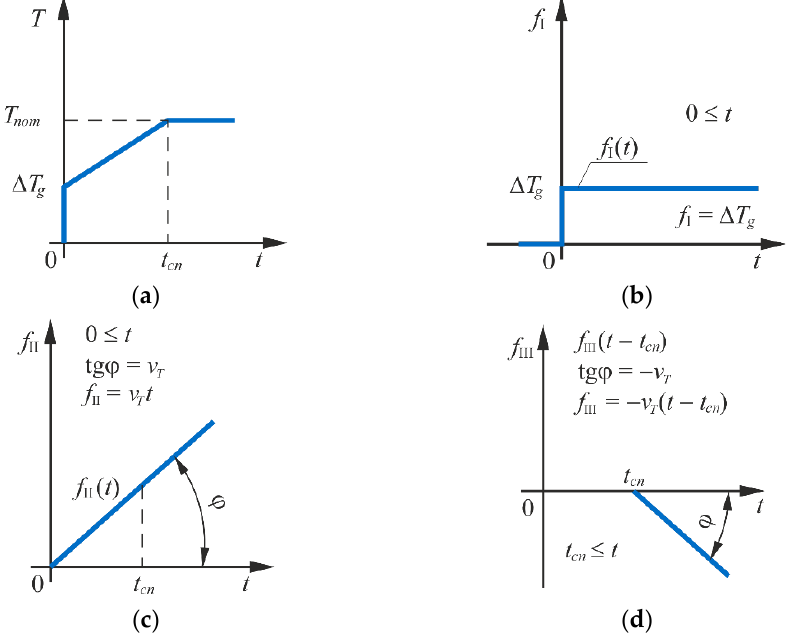
Figure 7. Changes in gas temperature over time at the accumulator inlet ( a ), which were decomposed into three components according to the superposition method: f I ( t ) ( b ), f II ( t ) ( c ), and f III ( t − t cn ) ( d ).